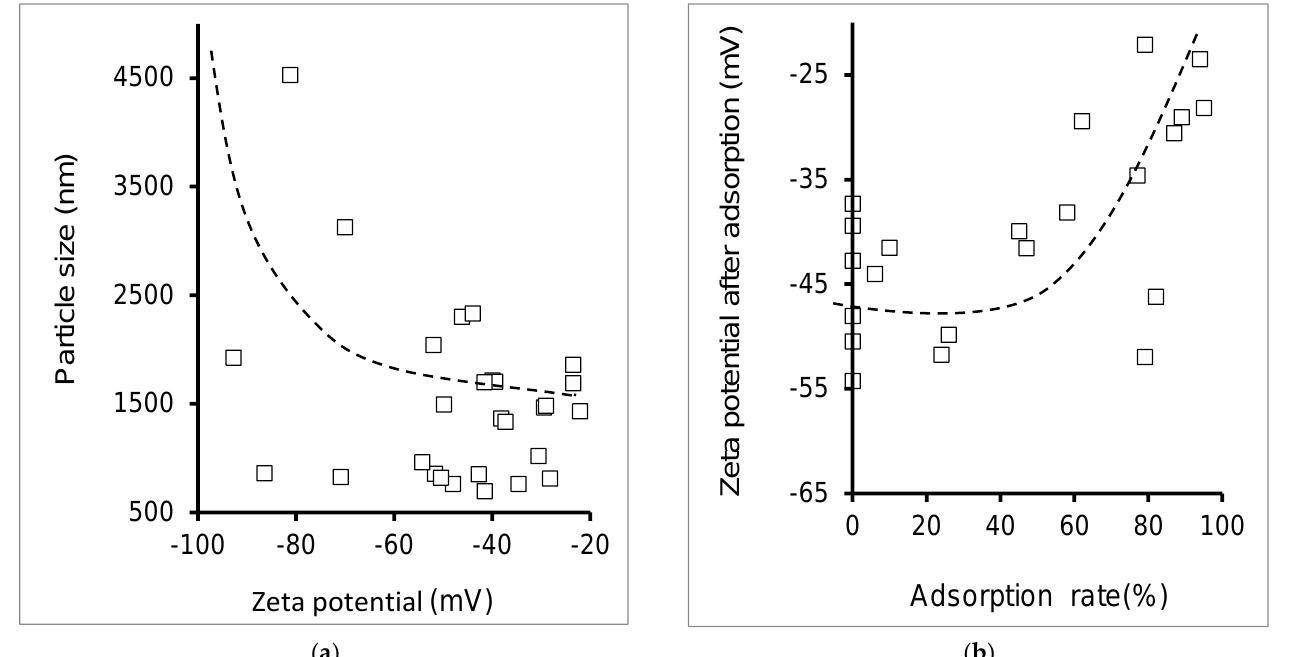
Figure 2. Effect of the Zeta potential on the particle size of Fe(II)Mt and HMt − 1 ( a ) and of the adsorption rate on the Zeta potential after adsorption ( b ) for all the organic species .